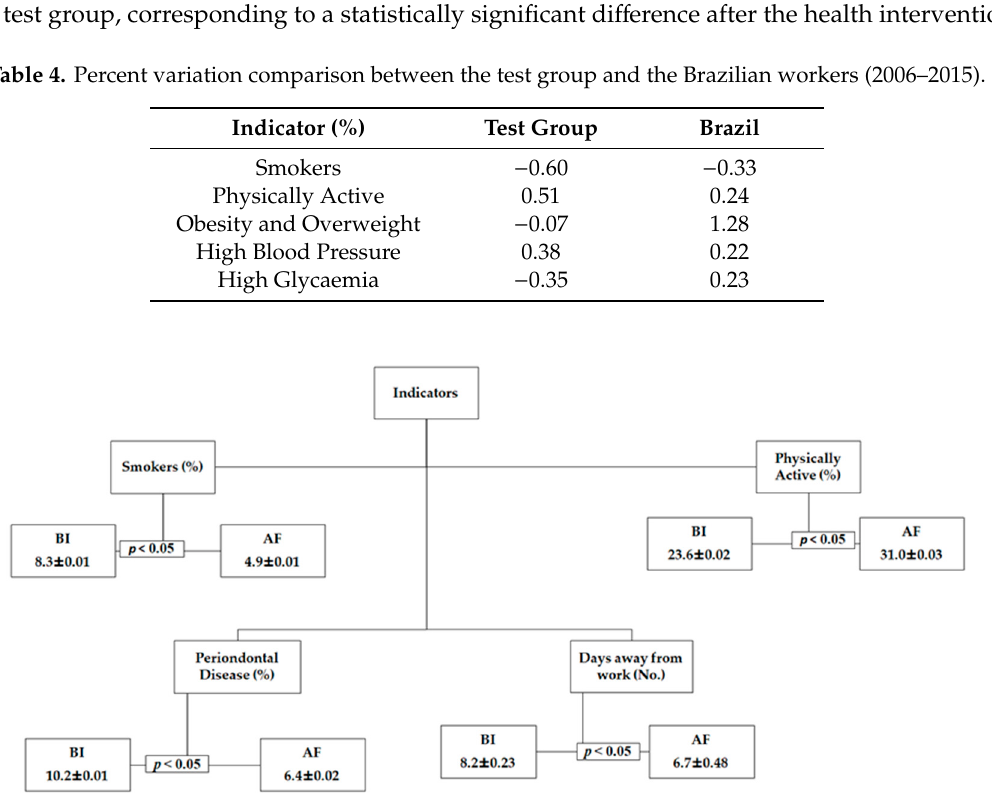
Figure 1. Group indicators corresponding to significant statistical differences after health intervention. Note: (BI) Before Intervention; (AF) After Intervention. Significant differences are presented in bold ( p < 0.05).